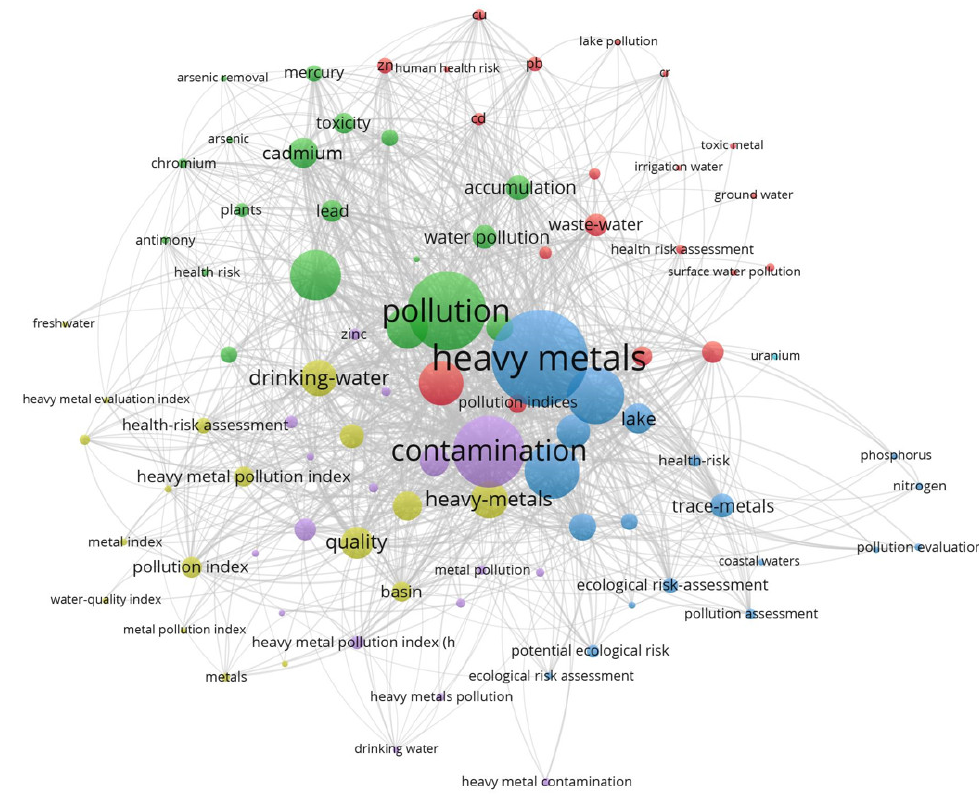
Figure 1. Meta-analysis of areas of interest in the literature on heavy metal water pollution.